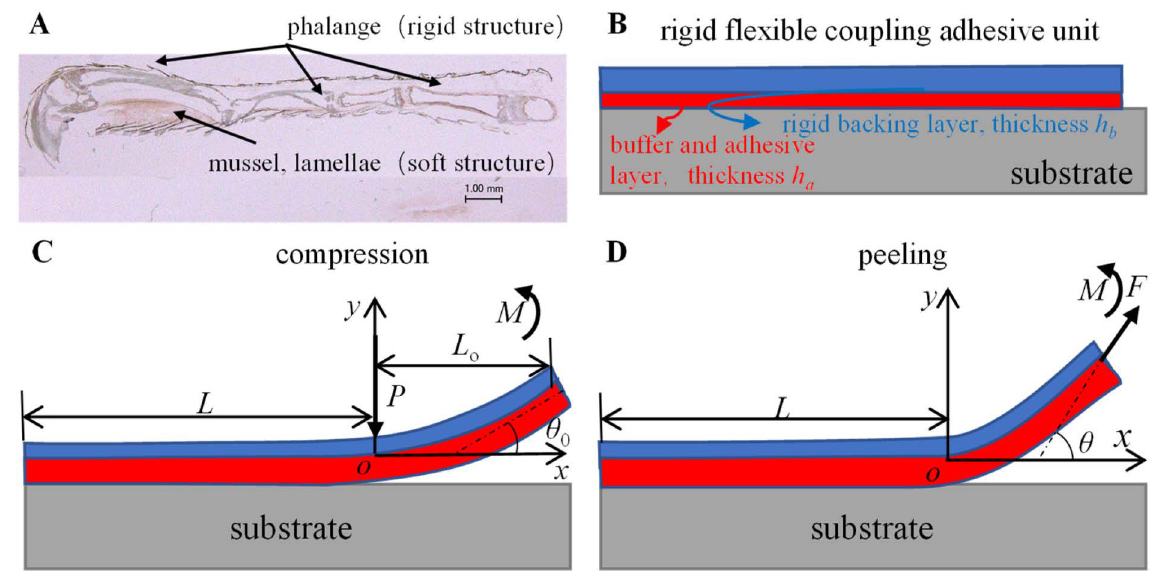
Figure 1. ( A ) Rigid-flexible coupling biological structure of gecko toes; ( B ) geometric model and mechanical analysis of rigid-flexible coupling adhesive unit during the ( C ) compression and ( D ) peeling